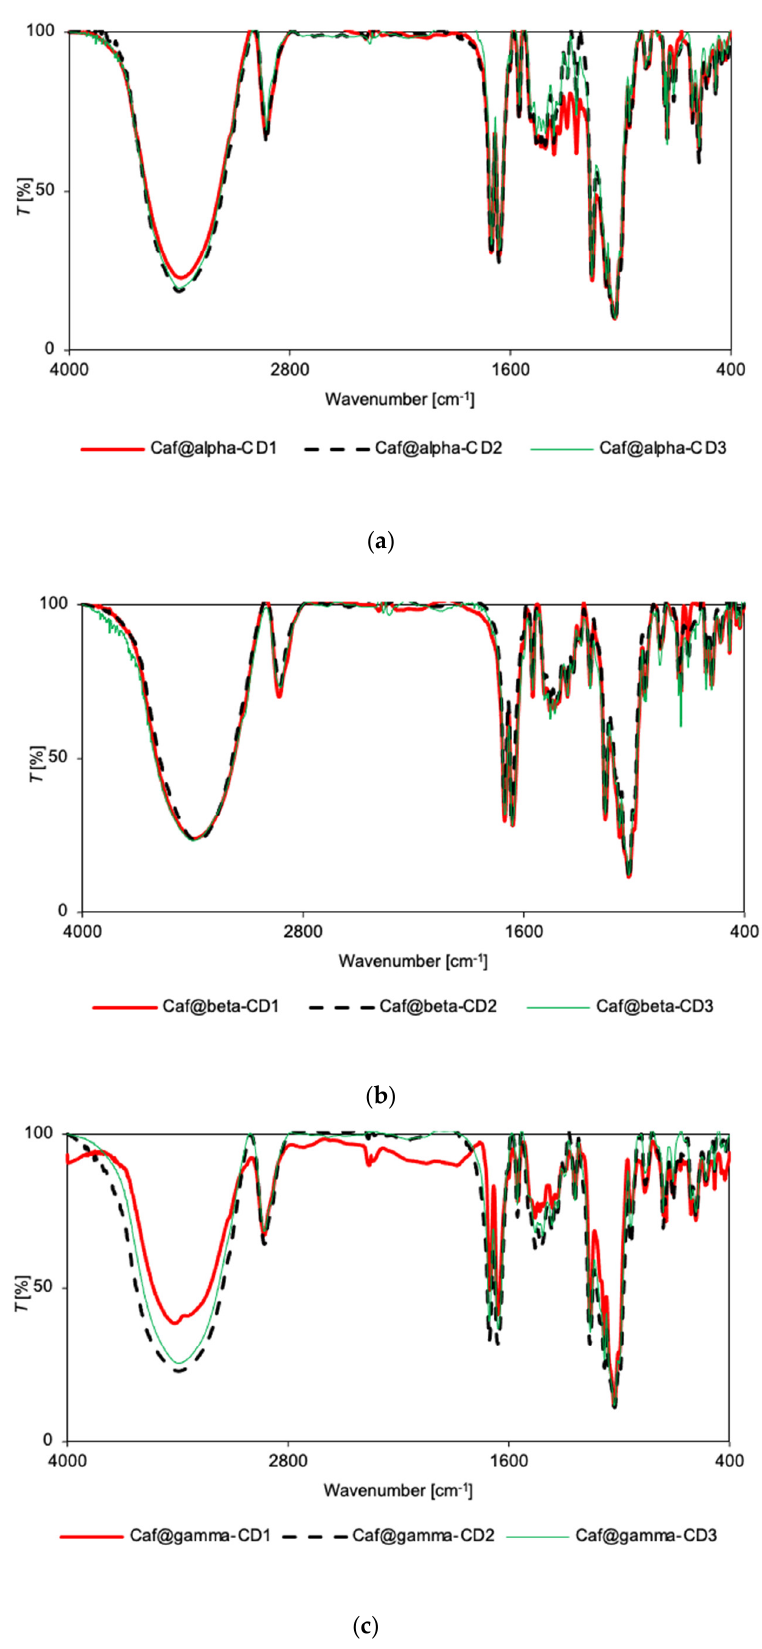
Figure 3. FT-IR spectra for Caf@CD obtained by three methods (1: cogrinding; 2: cogrinding with the addition of water drops; and 3: depositing from soln.). ( a ) α-CD; ( b ) β-CD; and ( c ) γ-CD series.